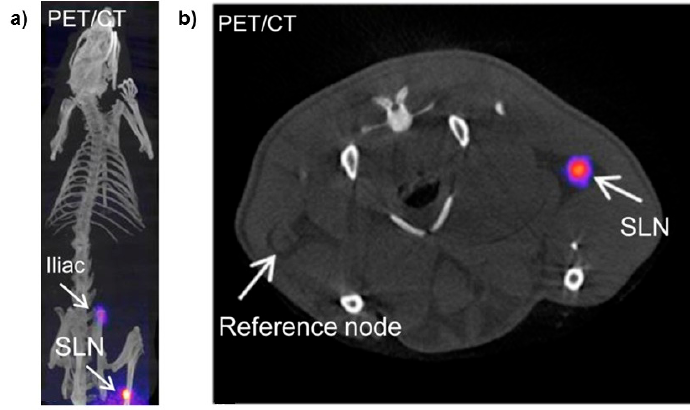
Figure 5. ( a ) PET/CT imaging 3 h post subcutaneous injection of 68 Ga-SPION. Arrow shows nanoparticle accumulation in SLN (popliteal) and iliac nodes; and ( b ) axial PET/CT slice 3 h post subcutaneous injection of 68 Ga-SPION. Arrows point SLN and reference nodes. Adapted from Madru et al.